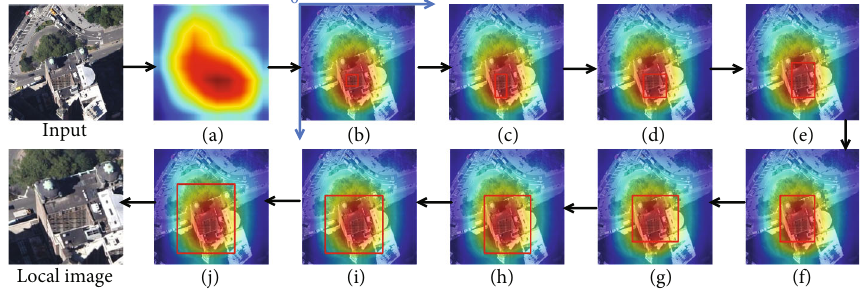
Figure 3: Visualization of local region localization: (a) the saliency map and (b – j) the process of single-object-based region